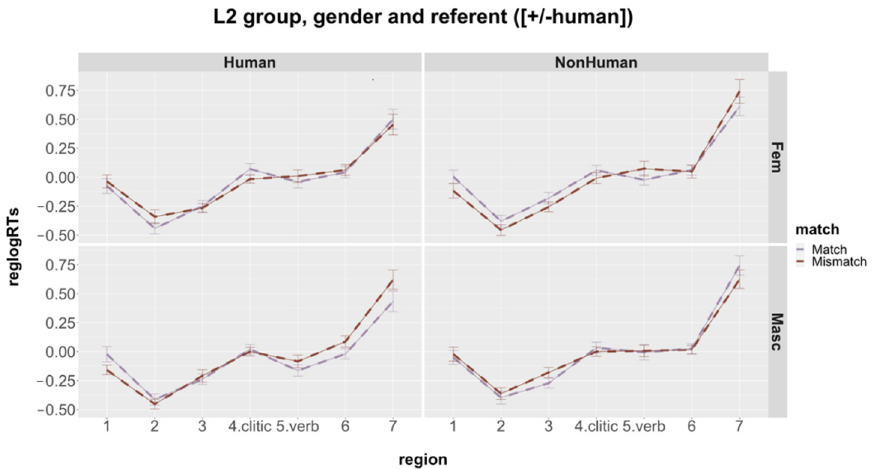
Figure 5. Length-adjusted, log-transformed reading times by region, L2 group.